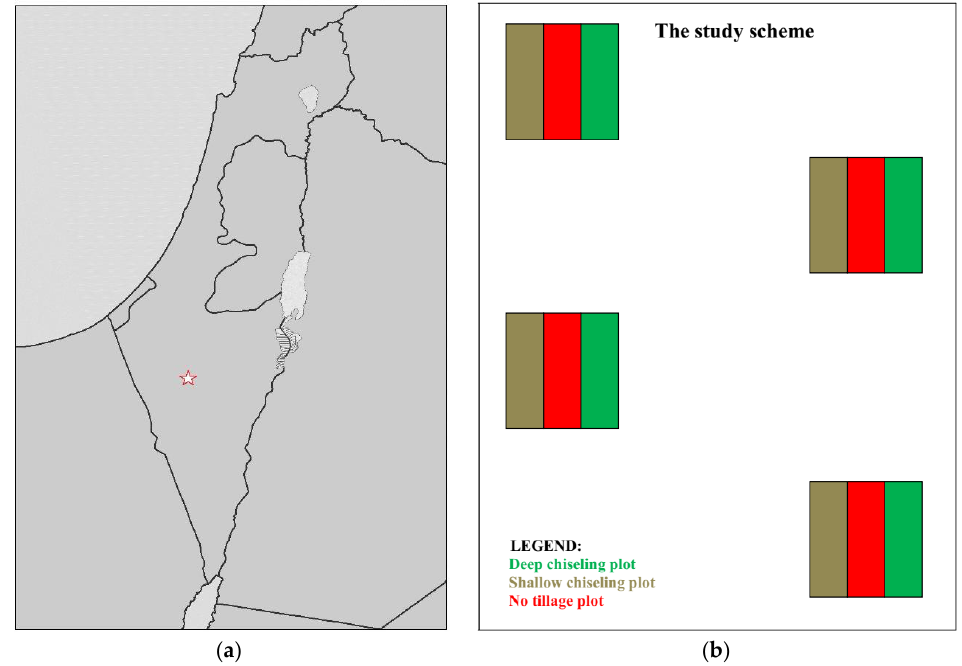
Figure 1. Map of Israel, with an indication of the study site ( a ); Schematic illustration of the study design ( b ).